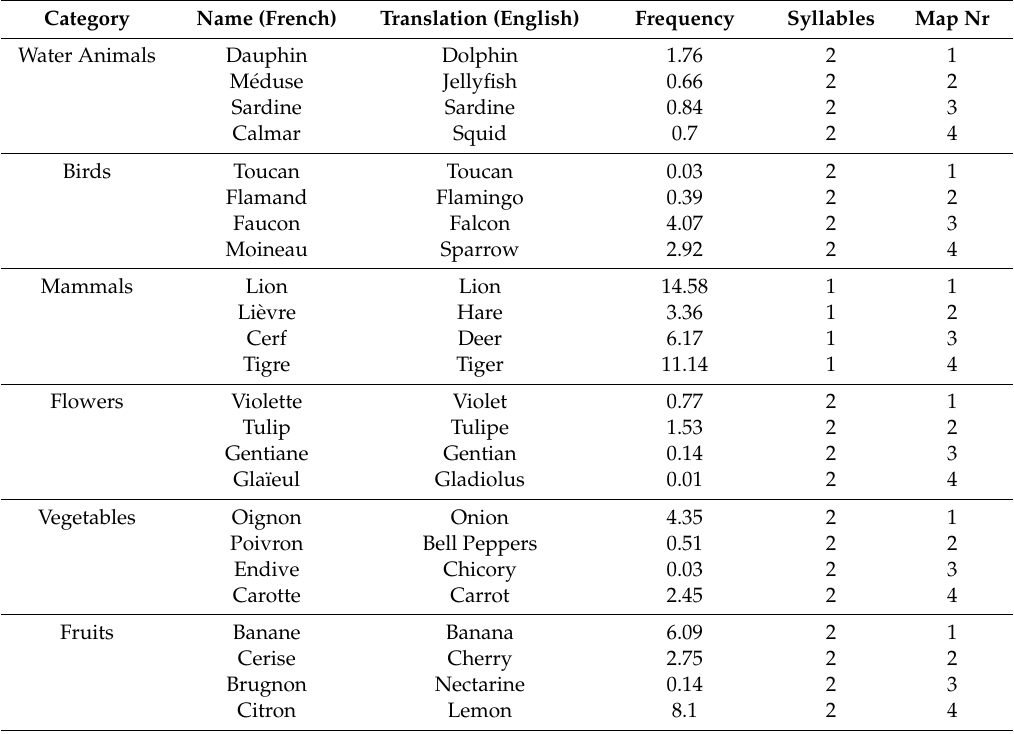
Table 1. List of map elements for the online